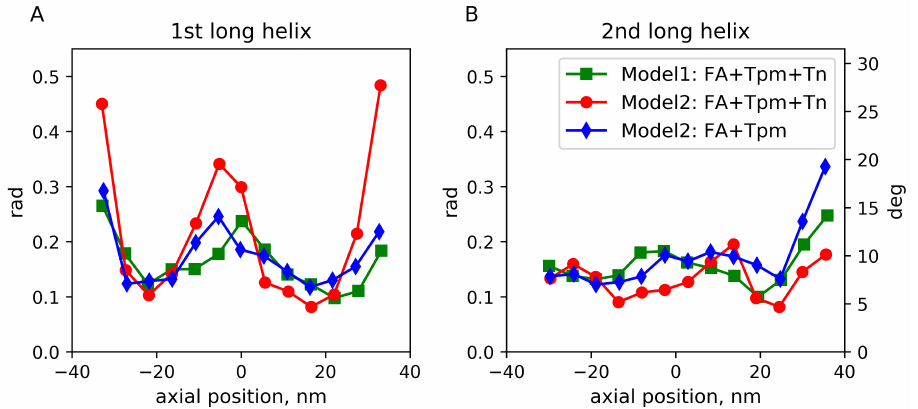
Figure 2. Root-mean-squared angular fluctuations of the long actin helices 1 ( A ) and 2 ( B ) bearing Tpm–Tn strands 1 and 2, respectively, for three MD runs: Model 1 (green) and Model 2 with Tn, short MD run (red) and without Tn, long MD run